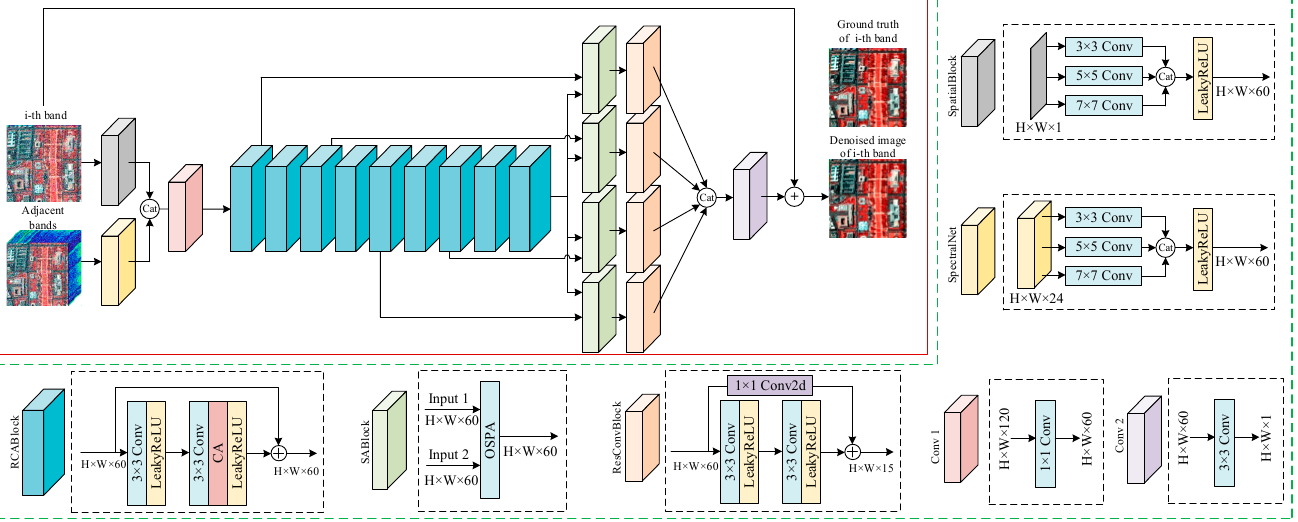
Figure 2. Flowchart showing the details of the proposed SPARCA-Net model for HSI denoising. The backbone of the network mainly consists of nine RCA blocks; all blocks